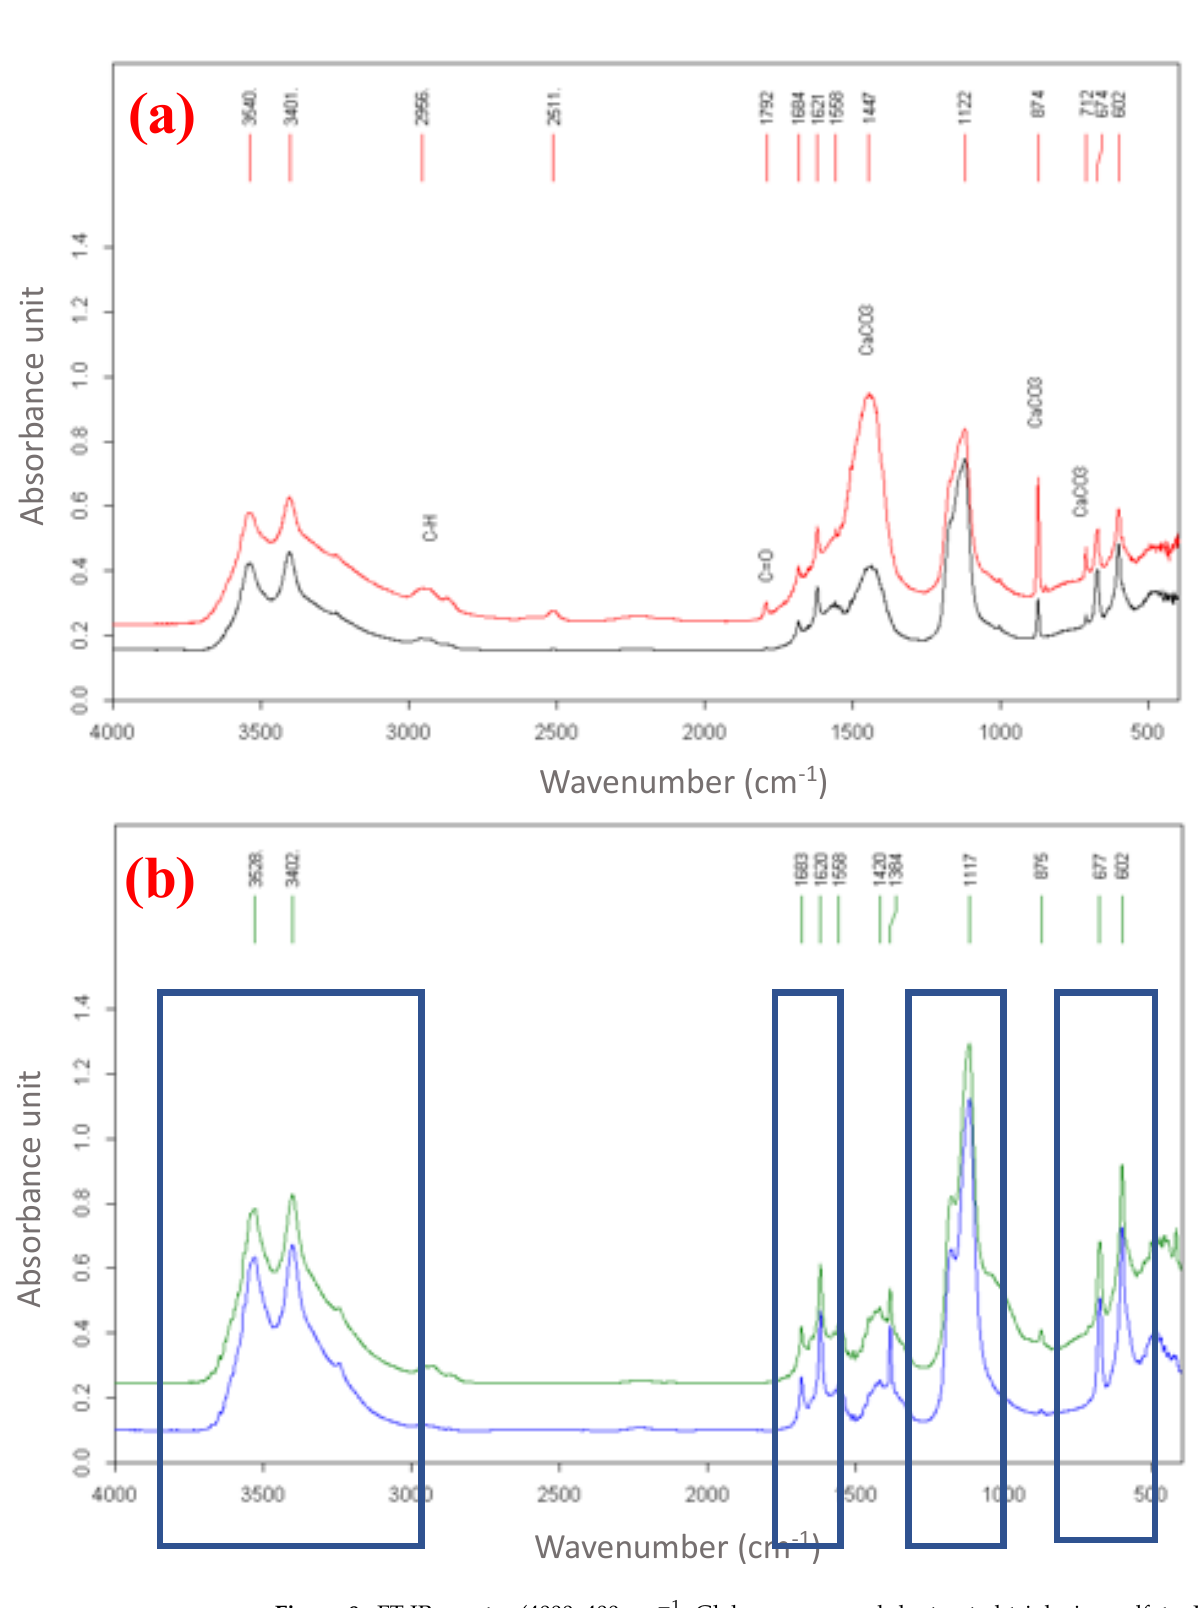
Figure 8. FT-IR spectra (4000–400 cm − 1 ; Globar source and deuterated triglycine sulfate, DTGS, detector; 200 scans; resolution 2 cm − 1 ) of samples taken from ( a ) wall and ( b ) floor (CaCO 3 875 cm − 1 ; CaSO 4 607 cm − 1 ). The red/black and green/blue spectra in figure ( a ) and figure ( b ), respectively, are related to two different samples from wall ( a ) and floor ( b ). The blue boxes show the signals due to calcium sulfate.